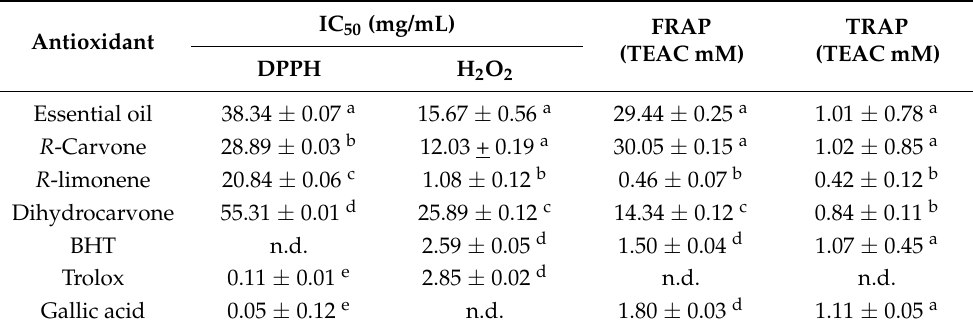
Different letters in the same column indicate significant differences; p < 0.05, n = 3, n.d.: not detected. While 2,2-diphenyl-1-picrylhydrazyl (DPPH) values indicate significant antioxidant activity of A. polystachya oil on aromatic herbal essential oils, such as rosemary ( Rosmarinus officinalis L.), cedar ( Cedrus libani ), and lemon balm ( Melissa officinalis L.) [17,18], it still